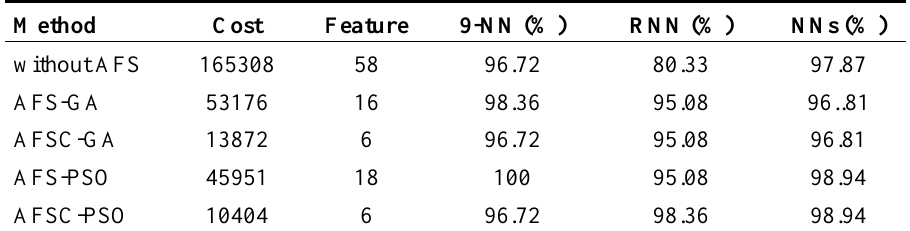
Table 8 . The AFS and AFSC results for eye-image data